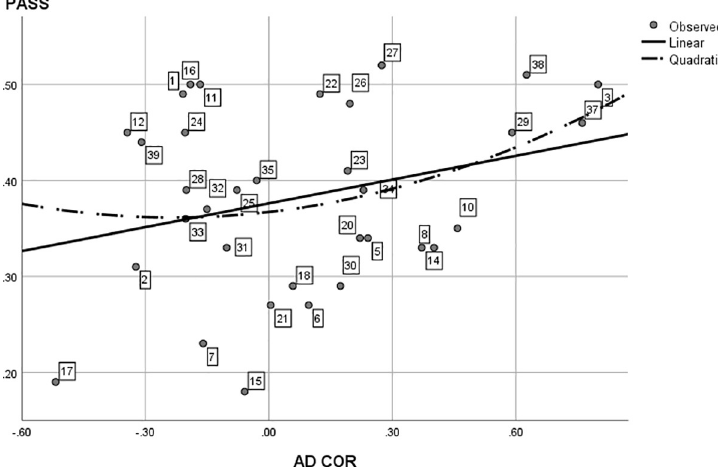
Fig 8. Post hoc Analysis: The (curvi)linear regression of average study program results (PASS) on study program interest diversity. The data points (study programs) are labeled analogous to Table 1 and are identical to Fig 5, with omission of points 4, 9, 13 and 19 that were discussed separately. With a pass rate of 0%, Geology (36) was considered an outlier and was removed from analyses.